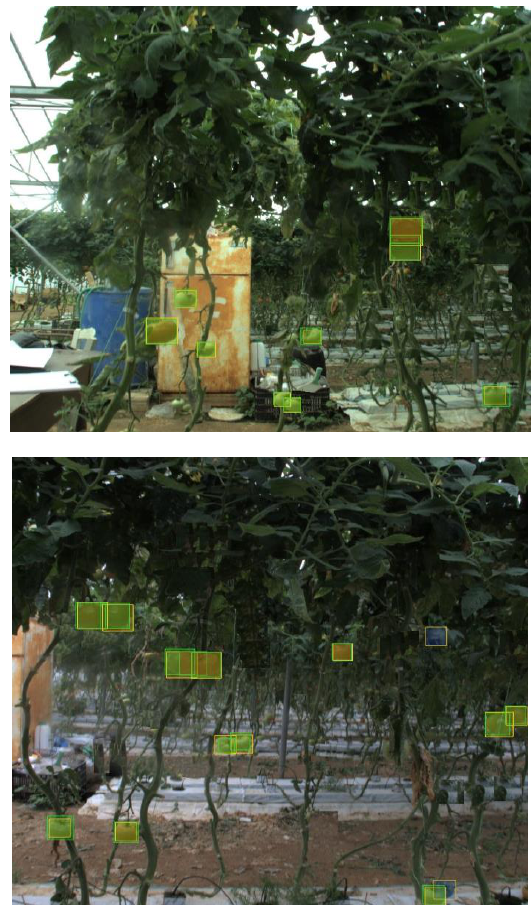
Figure 7. Detections of RetinaNet on two test images. The green outline indicates predictions and the yellow outline the ground truth. TP: green outline & fill; FP: green outline – red fill; FN: yellow ouline – blue fill